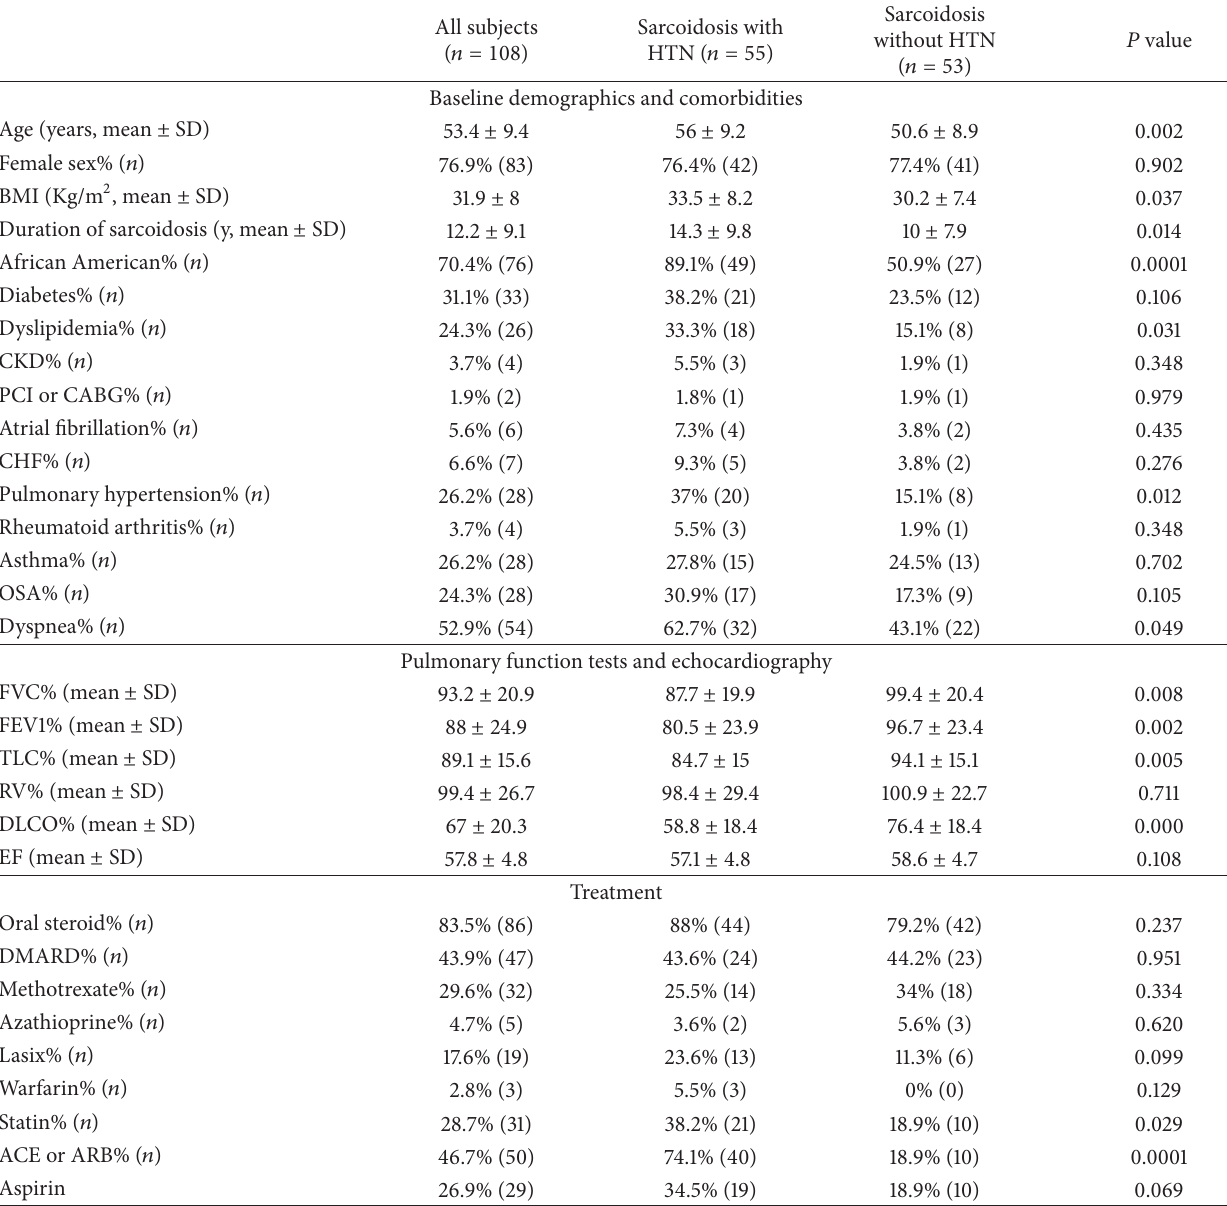
Table 1: Demographic and clinical characteristics of the sarcoidosis